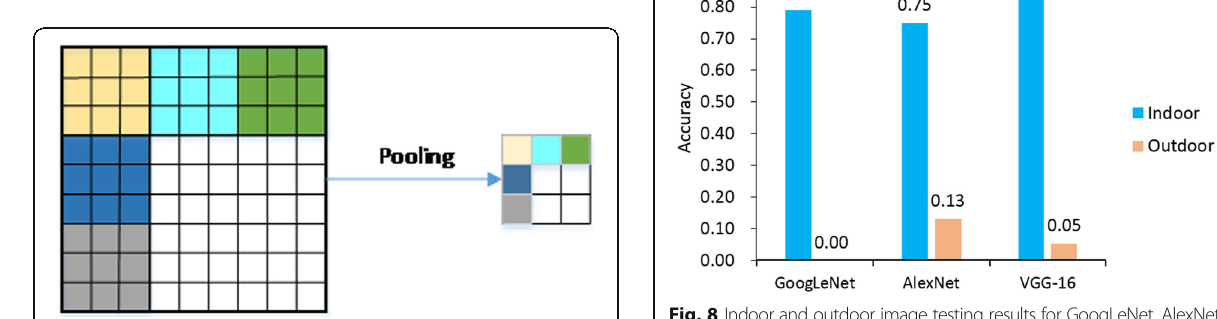
Fig. 8 Indoor and outdoor image testing results for GoogLeNet, AlexNet, and VGG-16 for